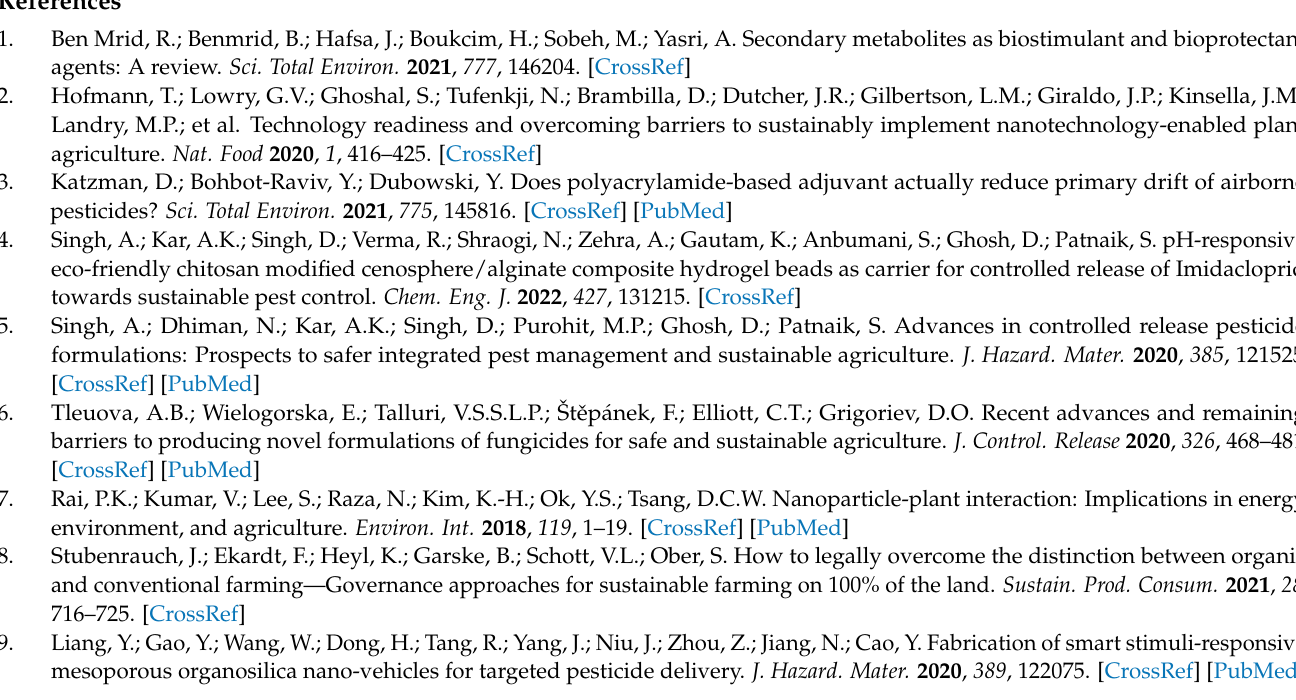
the fungicidal activity of ZIF-90 against Magnaporthe oryzae . Table S1: Surface and porosity properties of the samples. Table S2: Comparison of various carriers used to protect KSM from photolysis. Table S3: Fungicidal activity of KSM formulations as KSM aqueous solution and ZIF-90-KSM against Magnaporthe oryzae . References [29,41,42] were cited in the Supplementary